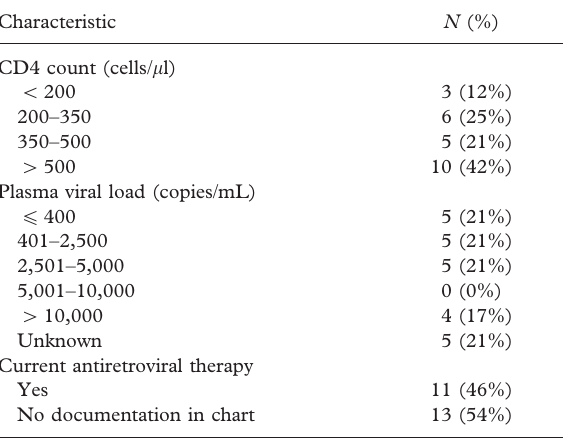
Table II. Characteristics of 24 HIV-infected women at time of surgery.